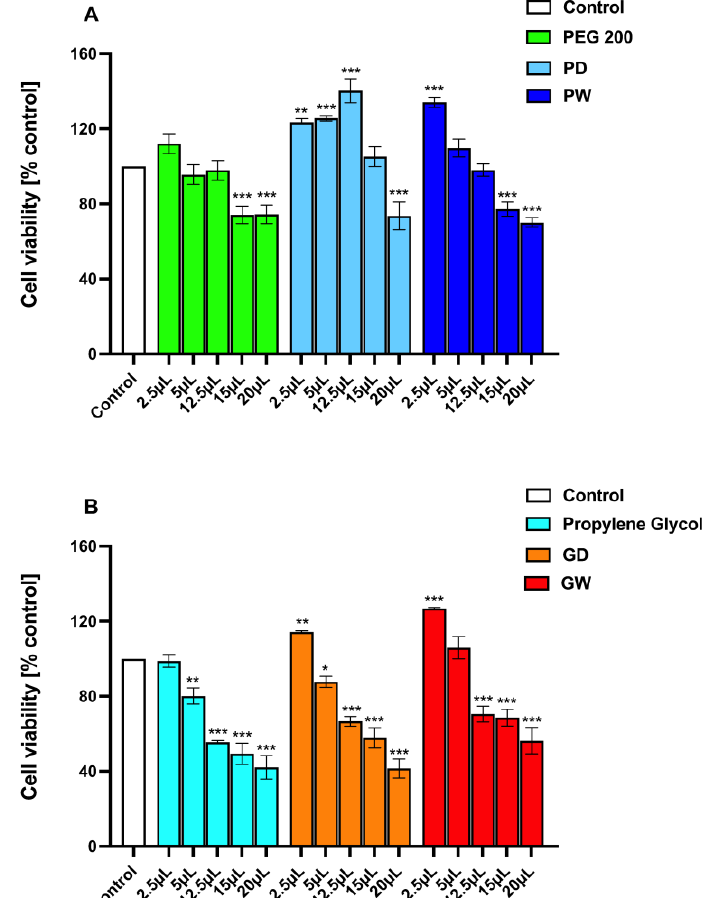
Figure 5. Cell viability assay on BALB/3-T3 cells. Cells were treated for 24 h in the absence (control) or the presence of ( A ) PEG200 and PEG-based extracts, ( B ) Propylene Glycol and Glycol-based extracts at different concentrations (2.5–20 µ L/mL). Values are means ± SD of three separate experiments conducted in triplicate. With respect to control, * p < 0.05; ** p < 0.01; *** p < 0.001 (ANOVA associated with Tukey’s test).